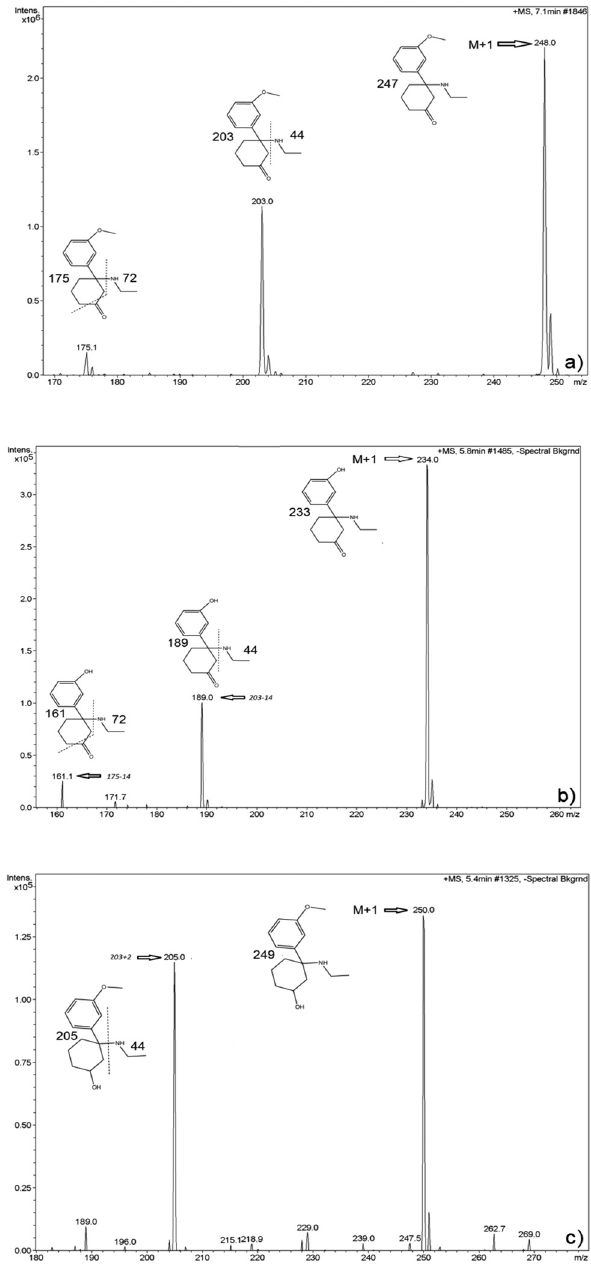
Figure 4: LC - MS data. ( a ) Mass spectra information for MXE with characteristic m / z ratios for the molecule at 247, 203, and 175; ( b ) mass spectra information for nor - MXE produced by O - demethylation with characteristic m / z ratios at 161, 189, and 233; and ( c ) dihydro - MXE produced by reduction of the ketone moiety with characteristic m / z ratios at 205 and